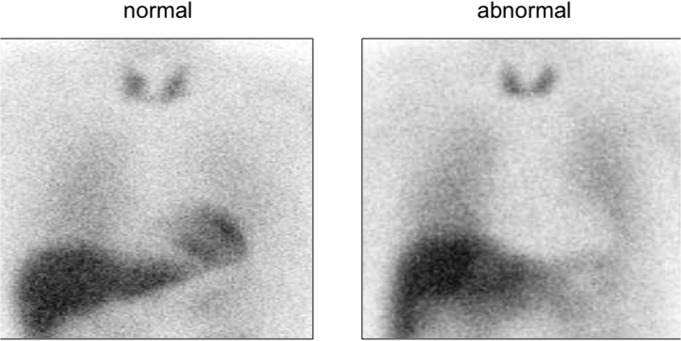
Normal and abnormal planar image of 123I-MIBG cardiac scintigraphy.